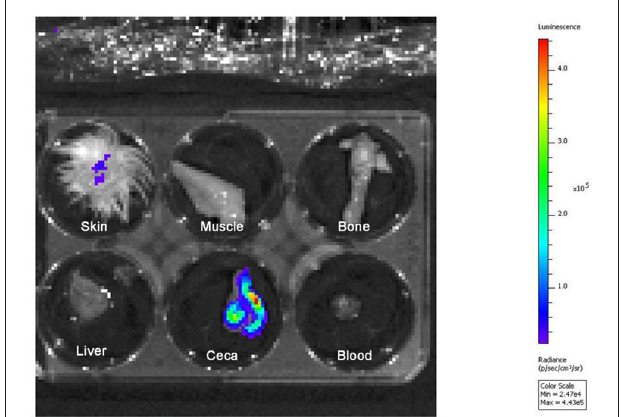
FIGURE 1 | Bioluminescence imaging in tissues of a 2-days-old chicken experimentally infected with S. Typhimurium- lux . Pseudocolor overlays represent the amount of bioluminescence produced by S. Typhimurium- lux in skin and ceca. The color scale indicates the amount of bioluminescence (surface radiance: p/s/cm 2 /sr) detected during